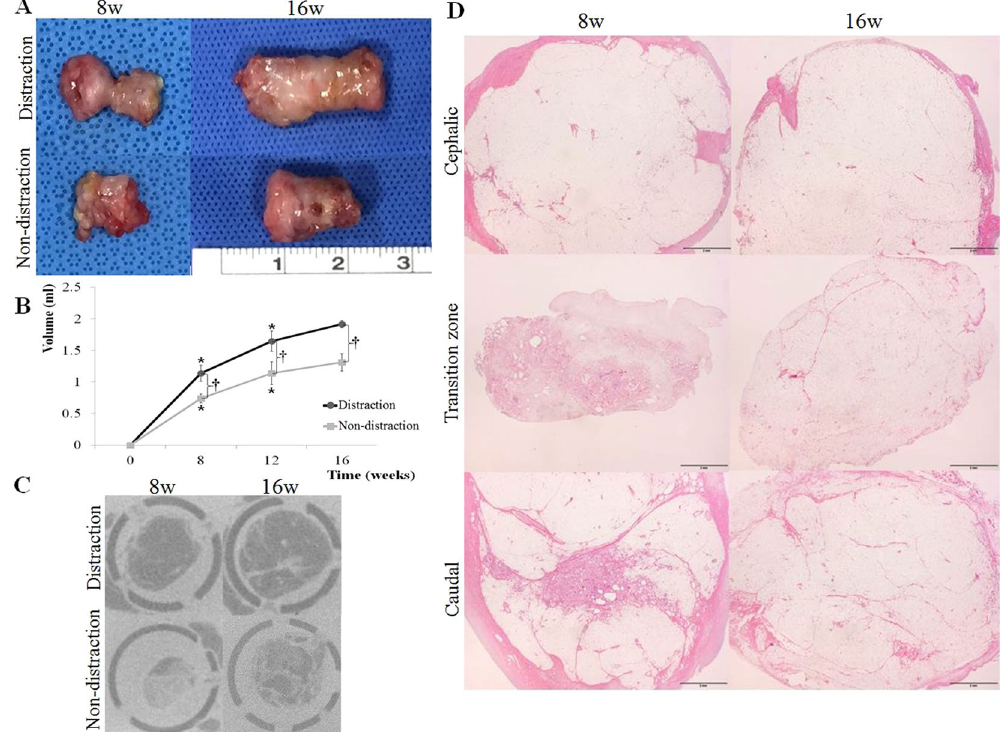
Figure 1. Gross observation ( A ), volume measurement ( B ), micro-computed tomography (CT) imaging ( C ), and cephalo-caudal microscopic observation ( D ) of the generated tissue in each group. In the distraction group, adipose tissue showed irregular contours, with a constricted transition zone, at 8 weeks. After 12 weeks of consolidation, adipose tissue construction was noted following volume expansion. In the non-distraction group the generated tissue exhibited pliable characteristics, with irregular contours, at 8 weeks. After 16 weeks, the adipose tissue had gained volume and fitted to the walls of the chamber ( A ). In the distraction group, the generated tissue volume gradually increased up to 16 weeks (final volume 1.92 ± 0.06 ml); nonetheless, significant expansion was noted at 8 and 12 weeks. The non-distraction group also exhibited a volumetric increment at 16 weeks (final volume 1.31 ± 0.14 ml), and significant increases were noted at 8 and 12 weeks. In comparative inter-group analysis, the distraction group volume was greater than that of the non-distraction group, indicating significant differences between groups at each time period (8, 12, and 16 weeks) ( B ). In micro-CT imaging, the distraction group exhibited adipose tissue formation in the central core at 8 weeks. At 16 weeks, enlarged adipose tissue occupied the chamber, with minimal connective tissue. Tissue generation was also noted in the non-distraction group, although the area was smaller compared with the distraction group. Tissue expansion had progressed at 16 weeks, but adipose and fibrous connective tissues were mixed ( C ). In histomorphologic analysis of the distraction group under low magnification ( × 10.25), the transition zone was small in diameter and exhibited inflammation at 8 weeks. Nonetheless, the area had enlarged and the inflammatory reaction had subsided at 16 weeks. The caudal area, adjacent to the caudally-based fat flaps, showed a connective tissue core at 8 weeks. Later observation at 16 weeks, nonetheless, exhibited adipose tissue components with septa ( D ). * p < 0.05, compared with measurement at the previous time point. † p < 0.05, compared with the non-distraction control